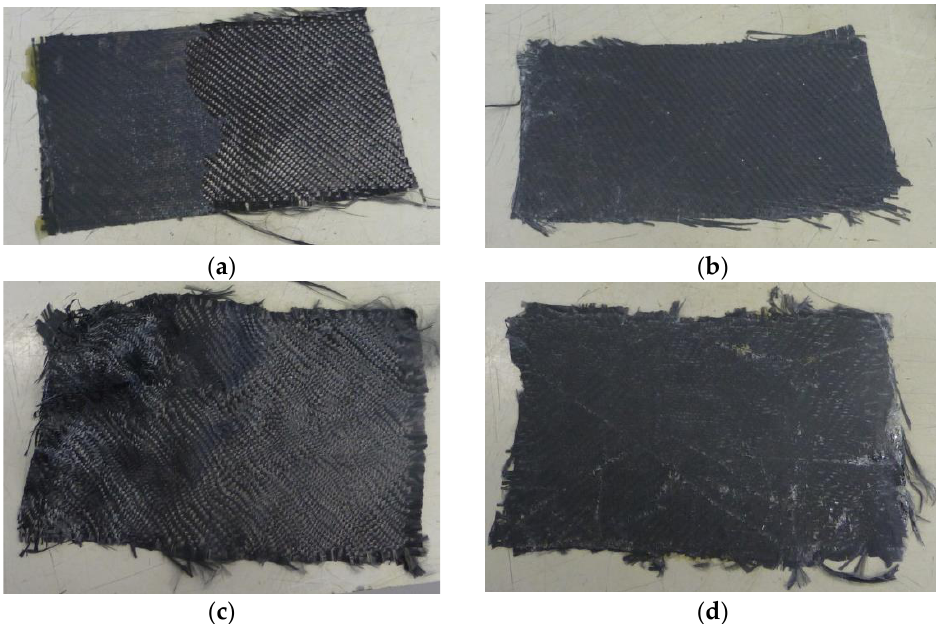
Figure 7. General view of the panel fabrics: ( a ) primary carbon fiber fabric; ( b ) recycled carbon fiber fabric; ( c ) primary carbon fiber reinforced plastic panel; ( d ) recycled carbon fiber reinforced plastic panel.